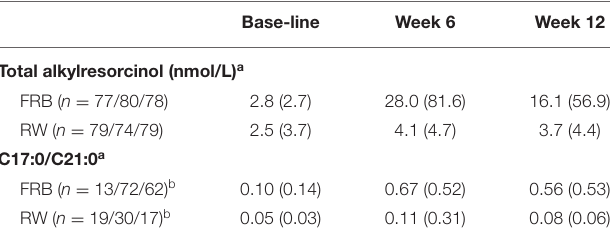
TABLE 3 | Plasma total alkylresorcinol concentration and the C17:0/C21:0 alkylresorcinol